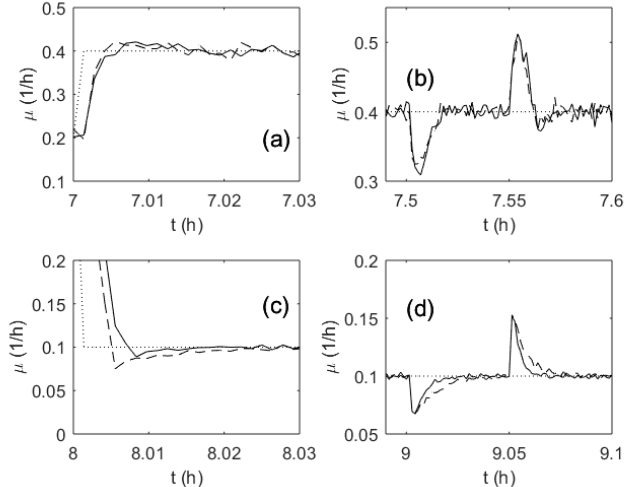
Figure 9. Transient processes of the specific growth rate during a test run: Setpoint change ( a ) and ( c ); disturbance rejection ( b ) and ( d ); the setpoint (dotted line); adaptive PI-based control (dashed line); ANN-based control (solid line).